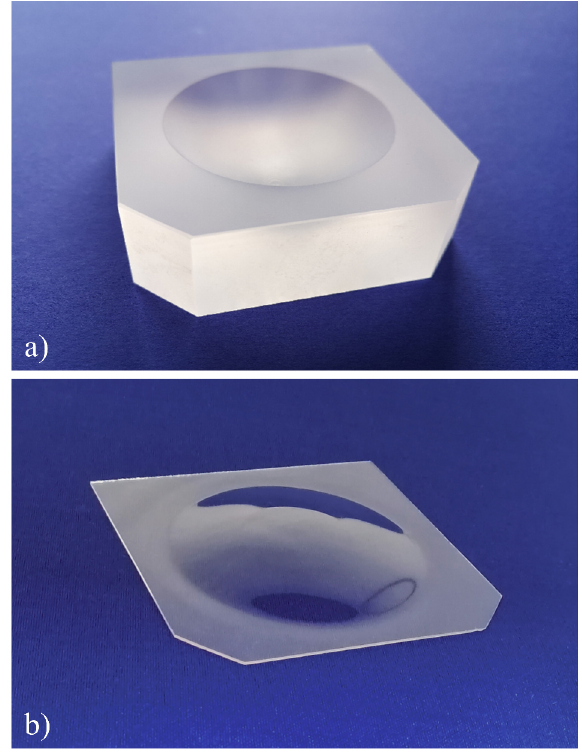
Fig. 4. Gravity-assisted bending of a parabolic